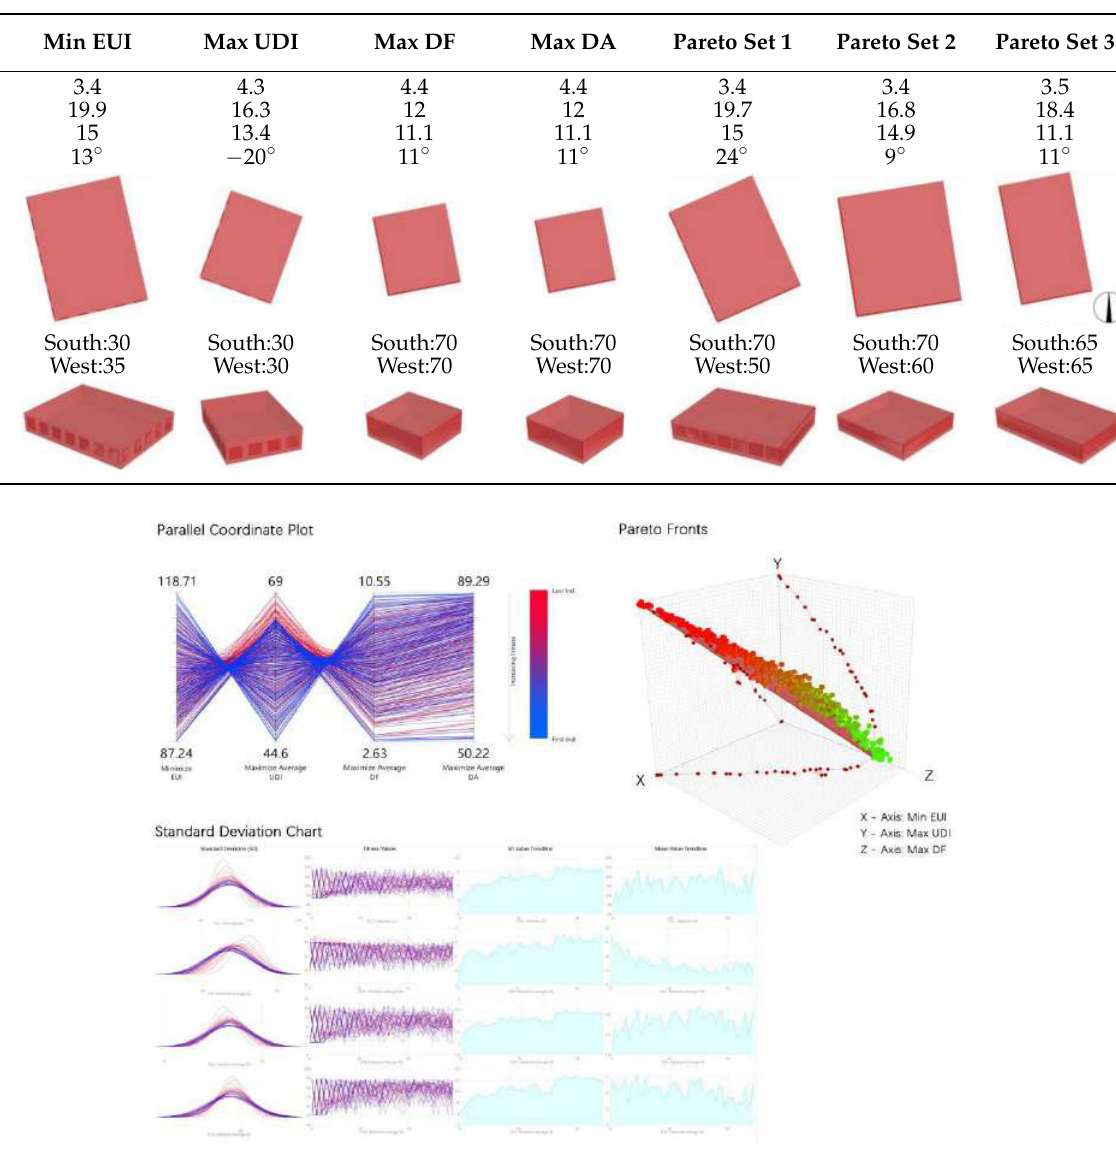
Table 16. Genomes in detail and phenotype outputs for large-sized classrooms with west and south facade fenestration.